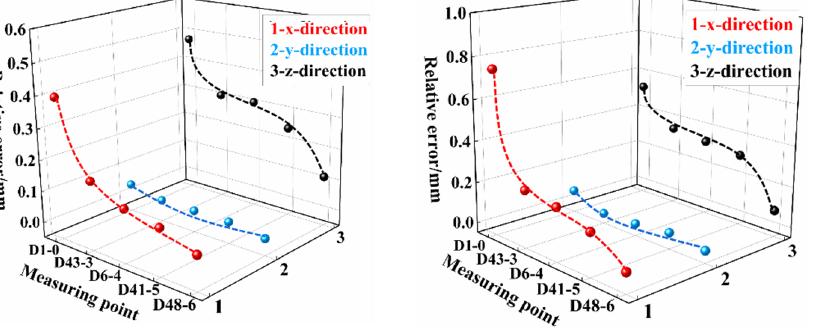
Table 10. Peak displacement of center-hung scoreboard.